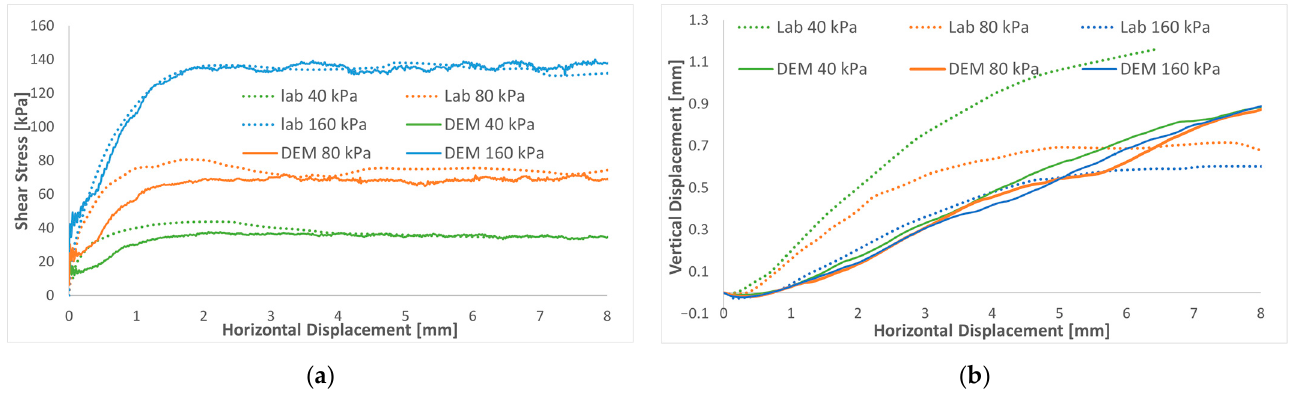
Figure 5. Comparisons between the DEM simulation and experiment (Salazar et al. [8]) for three normal stresses of 160, 80, and 40 kPa: ( a ) shear stress versus shear strain; ( b ) volumetric strain versus shear strain.